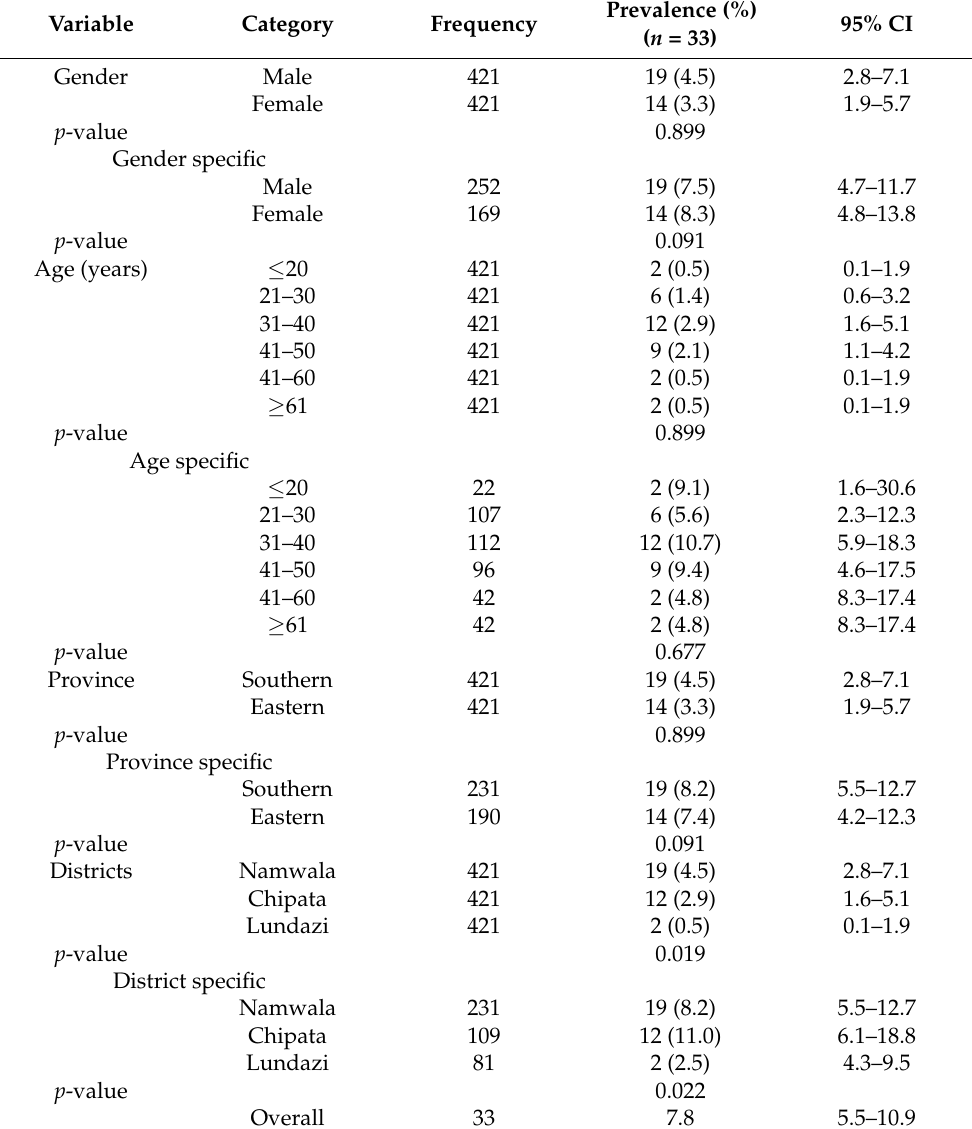
Table 1. Overall and specific prevalence of NTM in humans across age, sex, province, and